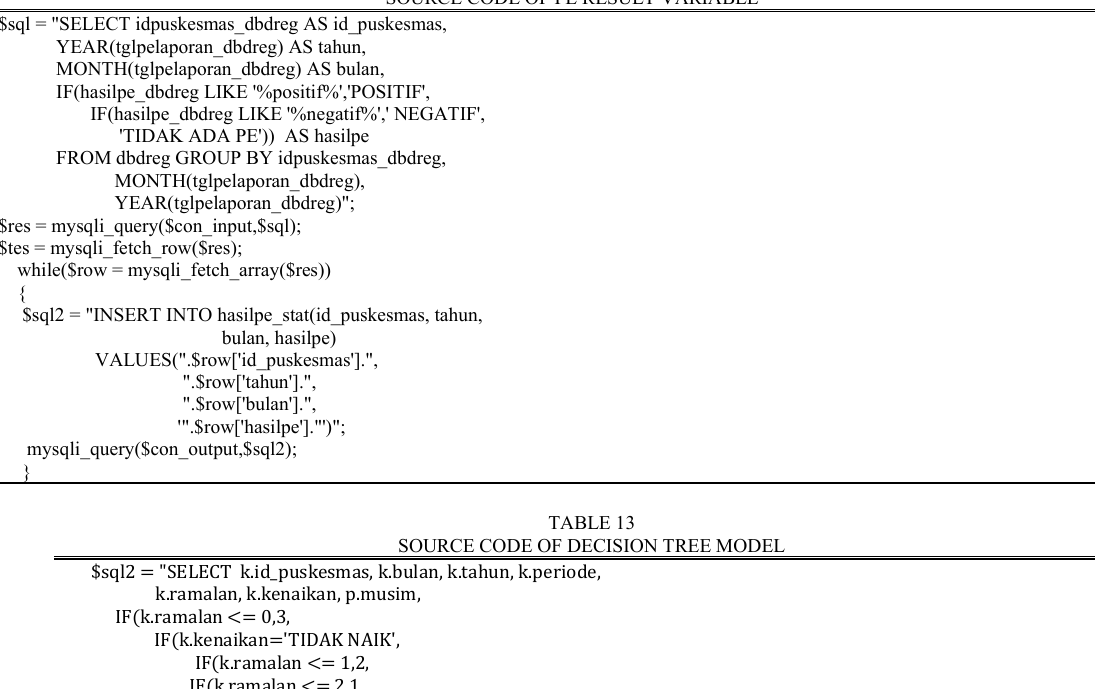
TABLE 12 SOURCE CODE OF PE RESULT VARIABLE